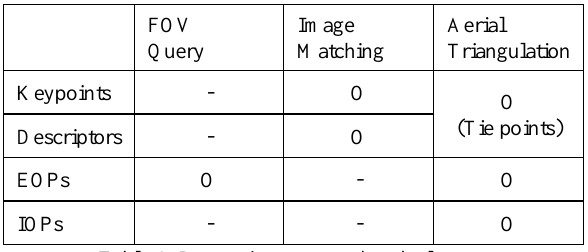
Table 1. Processing steps and each